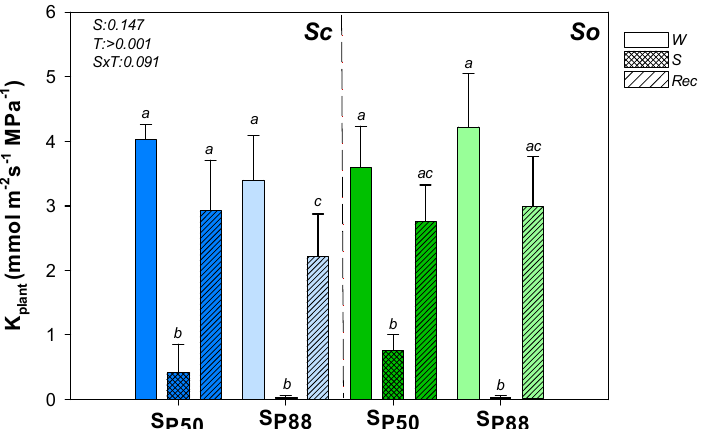
Figure 3. Effect of experimental treatments on plant hydraulic conductance. Mean ± SD ( n = 6) values of plant hydraulic conductance (K plant ) as recorded in well-watered (W, none pattern), water–stressed (S, slanting dash) and re-irrigated (Rec, mesh dash) plants of S. ceratophylloides ( Sc , blue columns) and S. officinalis ( So , green columns) submitted to two different water stress levels, i.e., S P50 and S P80 (for details, see the text). p values as obtained by the two-way ANOVA analysis are reported. Different letters indicate statistically significant differences between groups.